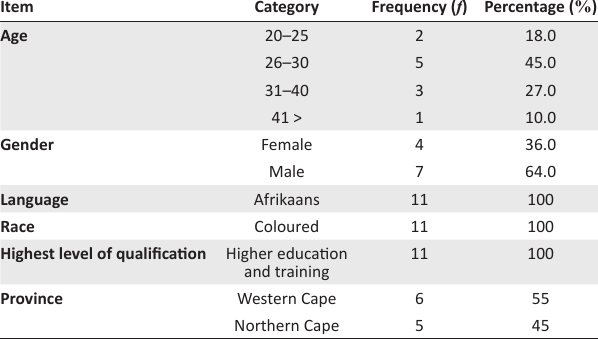
TABLE 1: Characteristics of participants ( N =